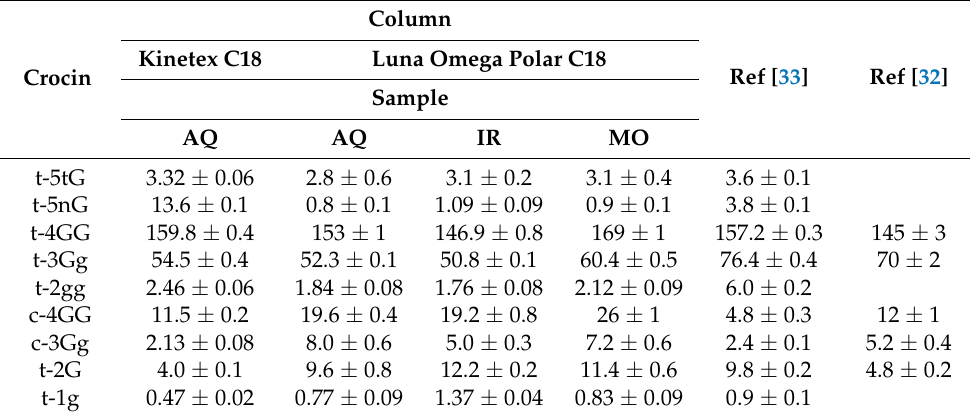
Table 3. Concentration (mg/g) of the major crocins found in the saffron samples analyzed in this work by UHPLC-DAD; average values and standard errors obtained in triplicate experiments and comparison with literature